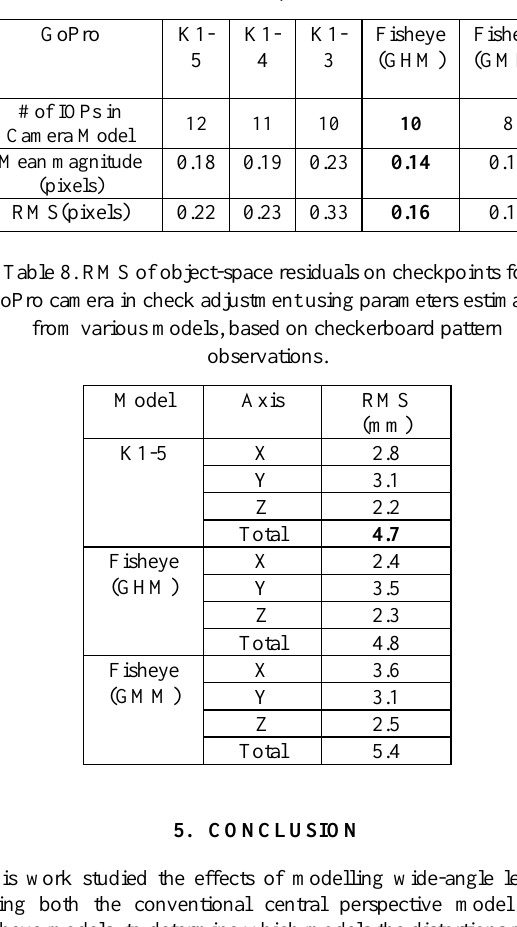
Table 7. Calibration Precision of GoPro Hero5 camera system using various calibration models in terms of image residuals, based on checkerboard pattern observations.